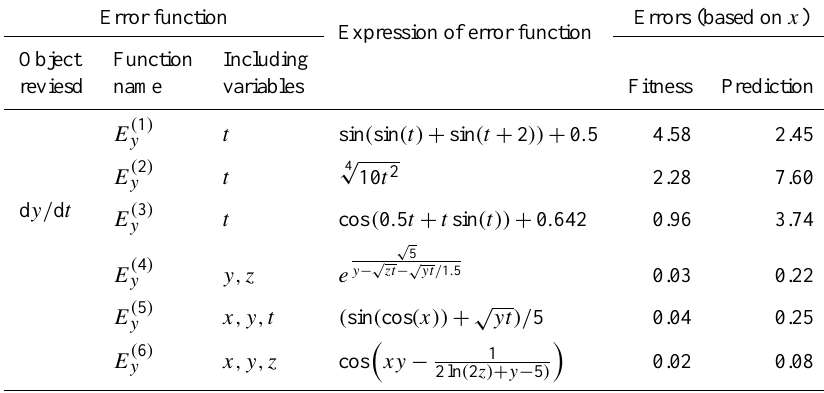
Table 3. Error functions and errors of the equations obtained by EM (for variable y ). Error function